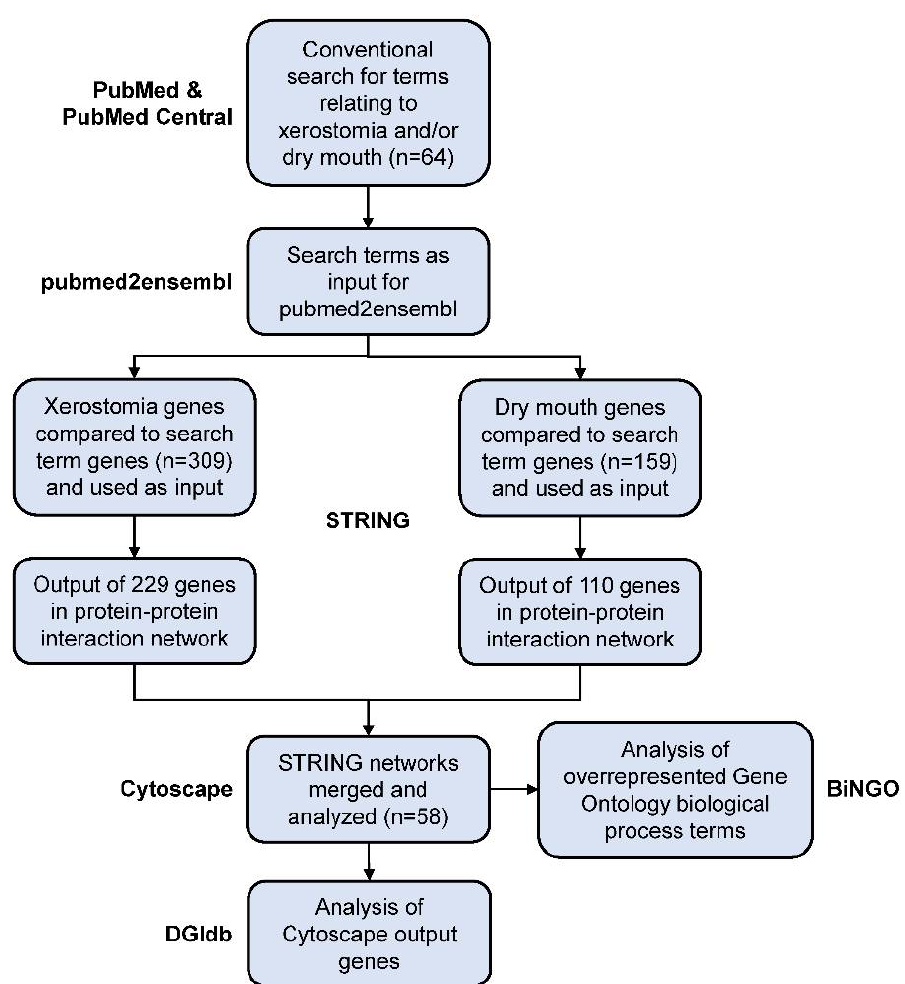
Figure 1. Overall Analytical Design. Search terms ( n = 64) were determined to be related to xerostomia and/or dry mouth. Using search terms as input, pubmed2ensembl identified 1916 genes (309 without duplicates) and 1134 genes (159 without duplicates) to be related to xerostomia or dry mouth, respectively. Using STRINGv11.0, 229 genes were used as input for xerostomia and 110 genes were used as input for dry mouth with a confidence level of 0.90. STRINGv11.0 protein–protein interaction networks were used as input for Cytoscapev3.8.1 with a confidence score of 0.98. Network of 128 and 55 genes for xerostomia and dry mouth, respectively, were returned and merged, resulting in 58 genes with matching names or Ensembl IDs. The BiNGOv3.0.3 Cytoscapev3.8.1 app determined 360 gene ontology biological processes to be overrepresented in this intersection ( p < 1.0 × 10 − 4 ). From 58 genes, 54 were found to have drug–gene interactions via the drug–gene interaction database (DGIdb). Using 54 total candidate gene targets, 27 drug trials consisting of 18 different drugs were identified using ClinicalTrials.gov that have been or are being evaluated for efficacy in treating xerostomia in general, head and neck cancer-related salivary gland dysfunction, or Sjögren’s